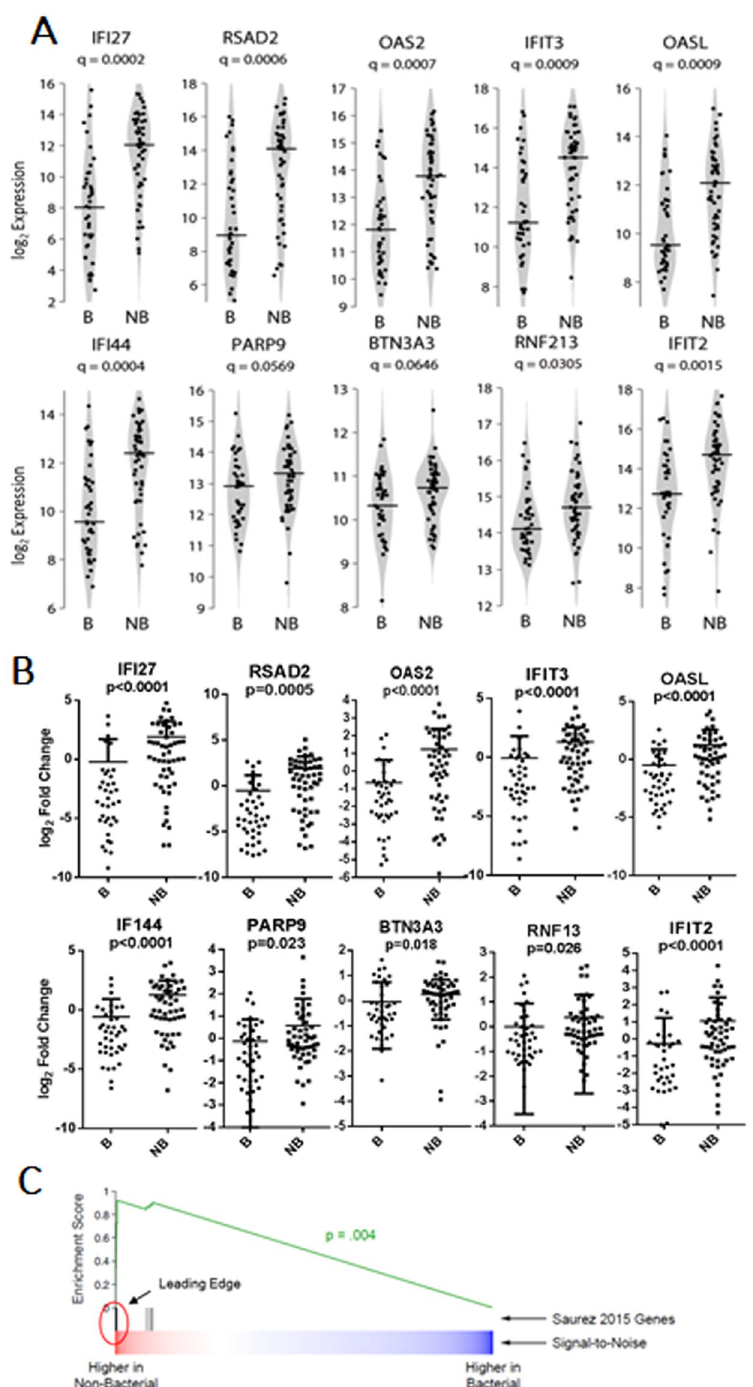
Figure 1. Replication of Array-Based Predictors. ( A ) Violin plots of RNASeq-based expression data for each of the 10 genes. Q-values for differential expression between bacterial and non-bacterial groups are indicated beneath the gene names. Horizontal lines indicate group medians. ( B ) Quantitative reverse transcriptase- polymerase chain reaction (qPCR)- based expression data for each of the 10 genes. P-values for differential expression between bacterial and non-bacterial groups are indicated beneath the gene names. Horizontal lines indicate group medians. ( C ) Gene set enrichment analysis plot for these 10 genes. Seven genes (vertical black lines) are contained in the leading edge of the enrichment